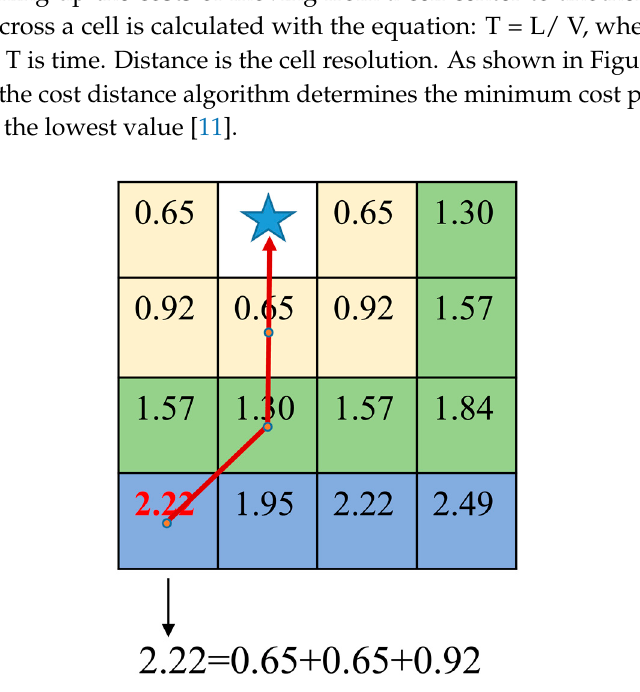
Figure 3. The response time for maritime SAR. It is calculated for each cell by summing up the costs of moving from a cell center to another through least-cost route.